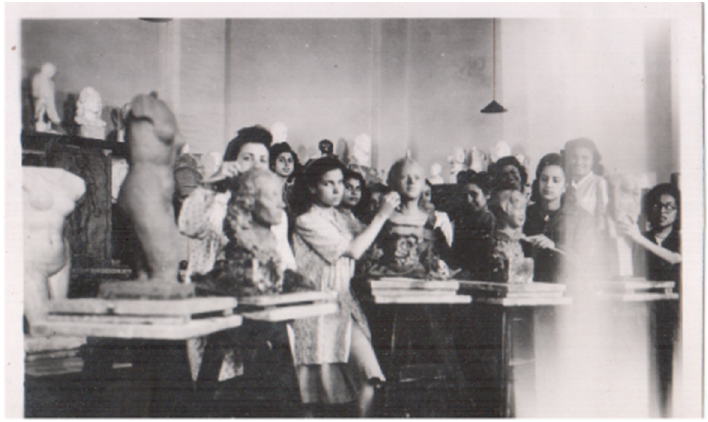
Figure 4. Photo from Art School (1947–1949). Courtesy of estate of Menhat Helmy.